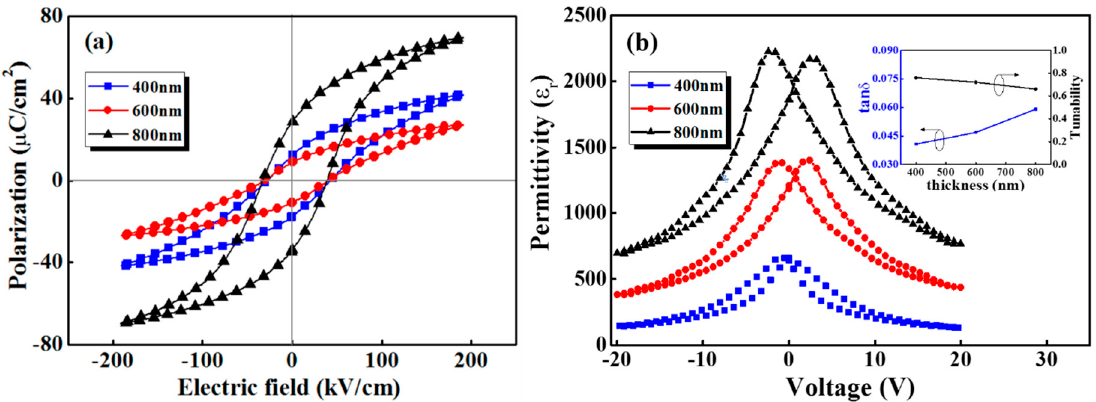
Figure 3. ( a ) Hysteresis loops and ( b ) permittivity vs voltage curves of PZT film with different thicknesses. The inset of ( b ) present dielectric loss and dielectric tunability of PZT film with different thickness.